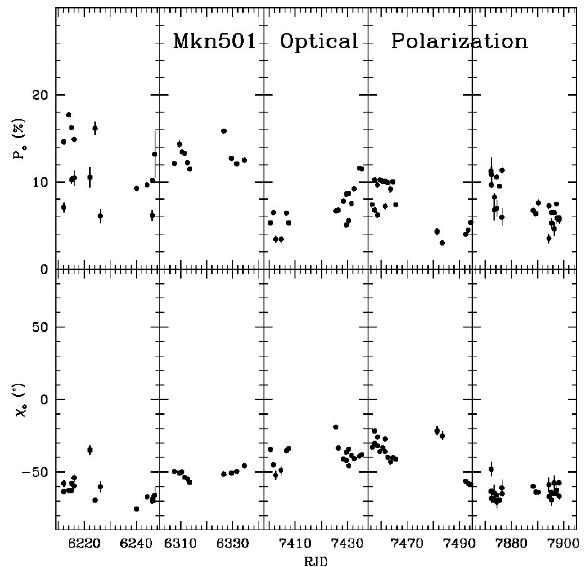
Figure 4. Optical polarization variability of Mkn501 during time intervals when the object was monitored with adequate time coverage. Data are from the data set displayed in Figure 3. The plotted points include data from Steward Observatory [49].